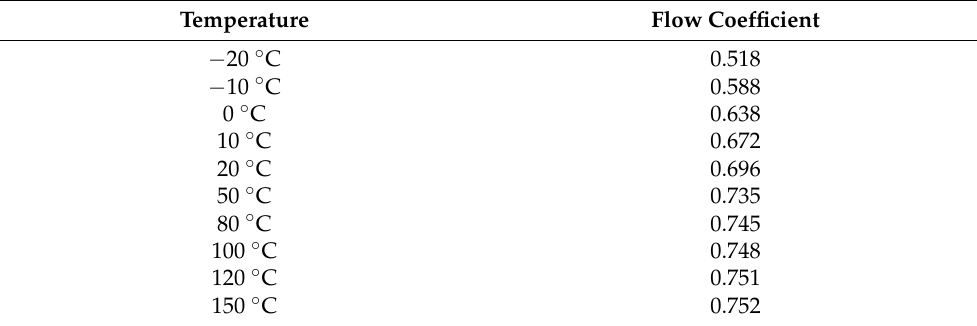
Table 2. The change of flow coefficient with